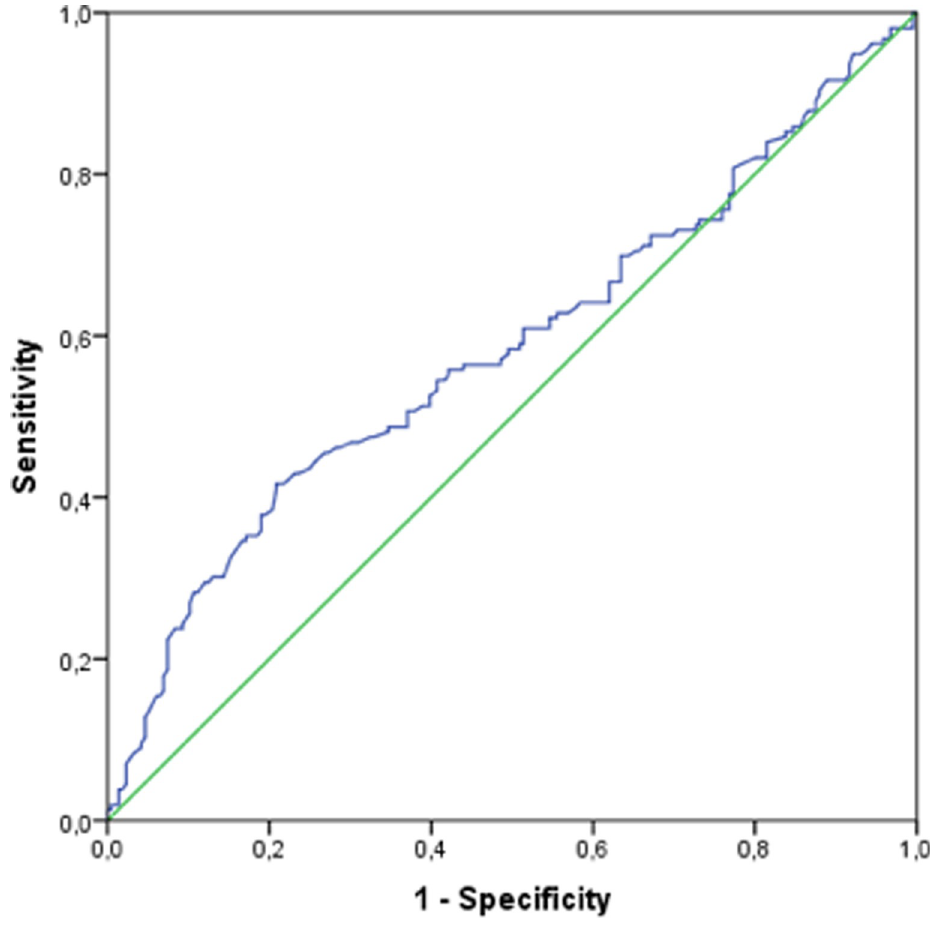
Fig 6. ROC curve for BW.